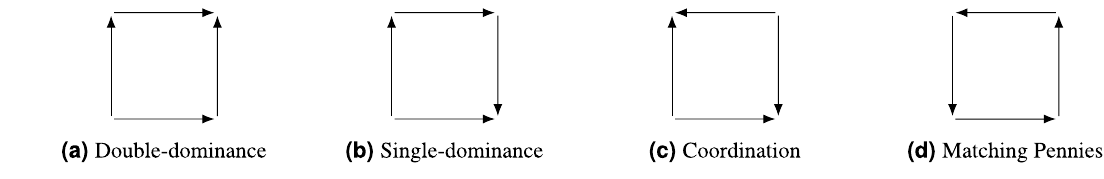
Figure 3. The four non-isomorphic response graphs of generic 2 × 2